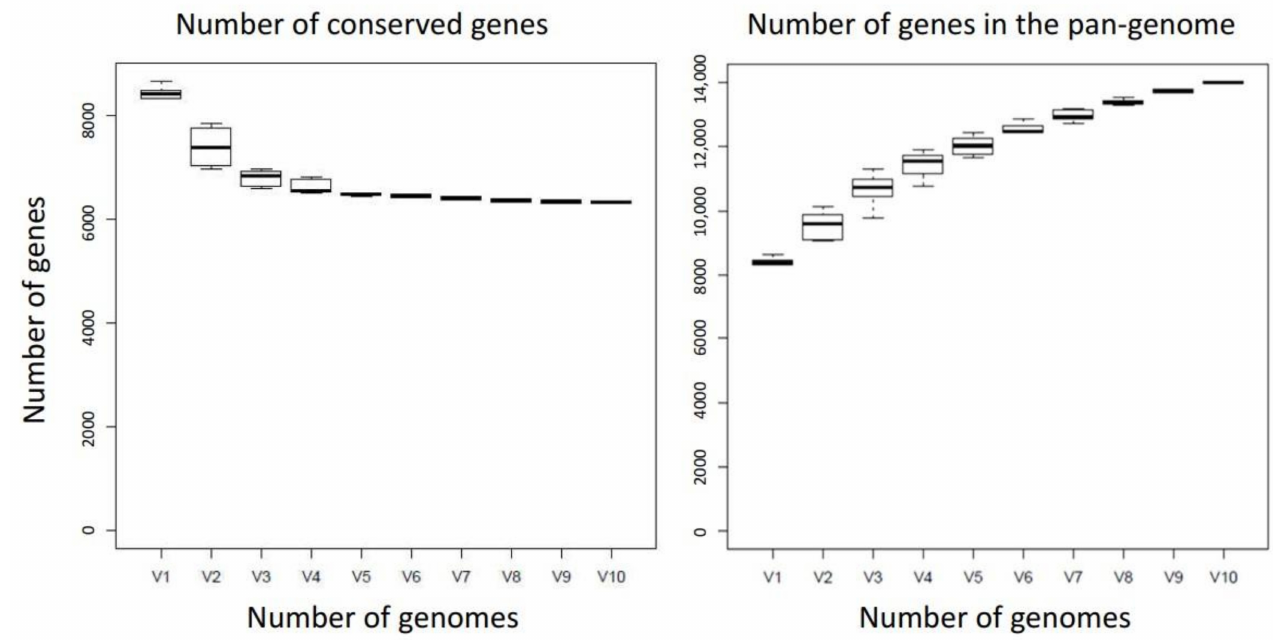
Figure 5. The Corallococcus exiguus pan-genome. The number of core genes ( left ) and total number of genes ( right ) for the pan-genome are shown as a function of the number of genomes included (V1–V10). Boxes show the median number of genes ± 1 standard deviation, whiskers show ± 2 standard